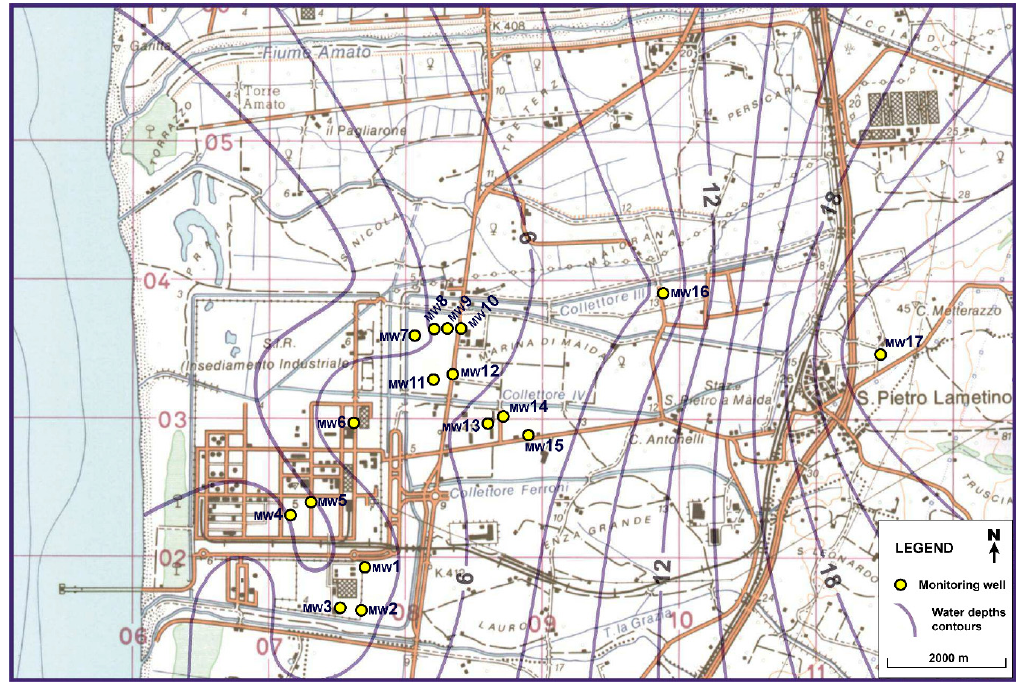
Figure 3. Map of the monitoring wells and two-dimensional groundwater level distribution (expressed in m above mean sea level).